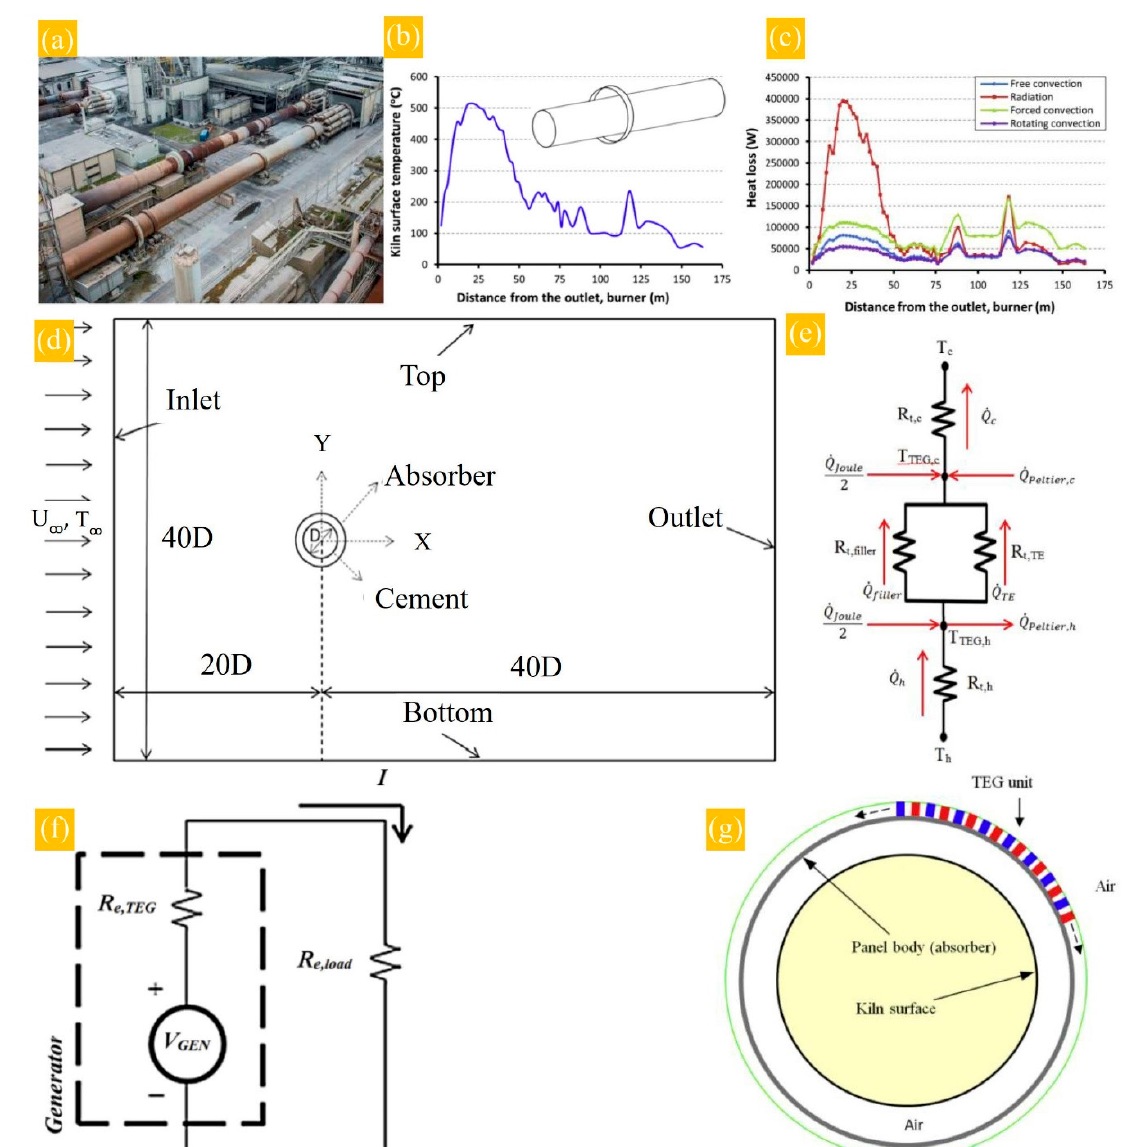
Figure 11. ( a ) A view of a cement rotary kiln in the Aalborg Portland cement factory, Aalborg, Denmark. Length 163 m, outer diameter: 3.6 m (adapted from [95] with permission), ( b ) temperature distribution along the kiln surface with a measurement interval of 2 m, inset: schematic illustration of the studied annular absorber (inset). The free stream air temperature (T ∞ ) and corresponding velocity (U ∞ ,) were considered as 5 °C and 5.86 m/s, respectively. The kiln rotational speed: 5 rpm (clockwise) (adapted from [95] with permission), ( c ) local heat loss through the kiln surface based on three heat transfer mechanisms, including free convection, forced convection, and radiation (adapted from [95] with permission), ( d ) schematic illustration of the 2D computational domain (adapted from [95] with permission), ( e ) one dimensional thermal equivalent electrical circuit (adapted from [95] with permission), ( f ) electrical resistance networks (adapted from [95] with permission), ( g ) schematic illustration of the thermoelectric unit on the panel (adapted from [95] with permission).